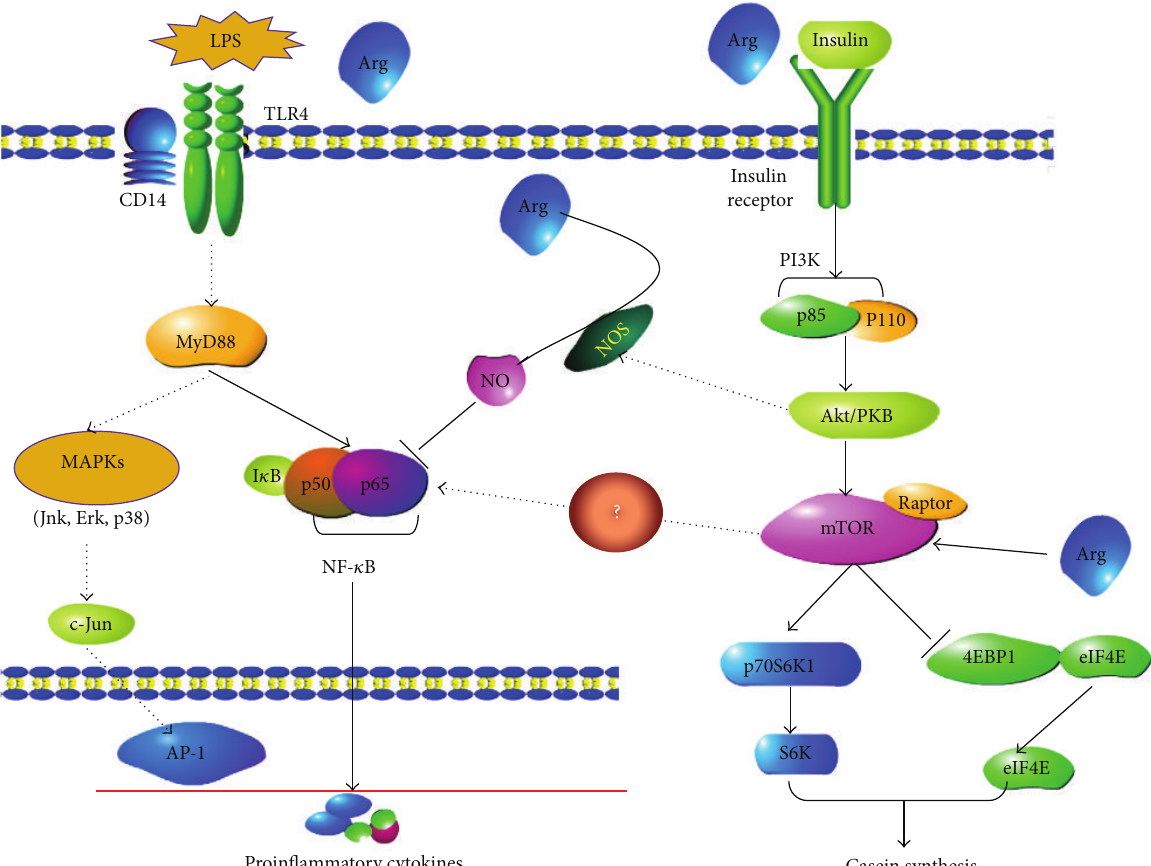
Figure 5: The potential mechanism that arginine relieves the inflammatory response and enhances the casein expression in bovine mammary epithelial cells induced by